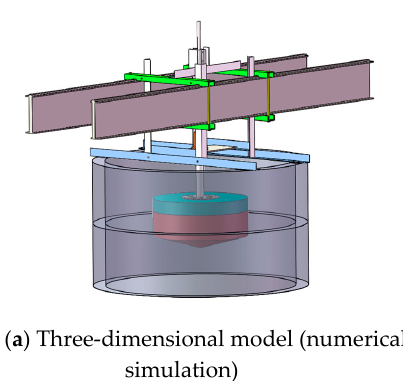
Figure 3. Moonpool-buoy device: on the left, 3D Computer Aided Design (CAD) schematics, with the central float in blue and red, the outer cylindrical shell in grey, and the connections to the above structure. On the right, a picture of the device in the tank.